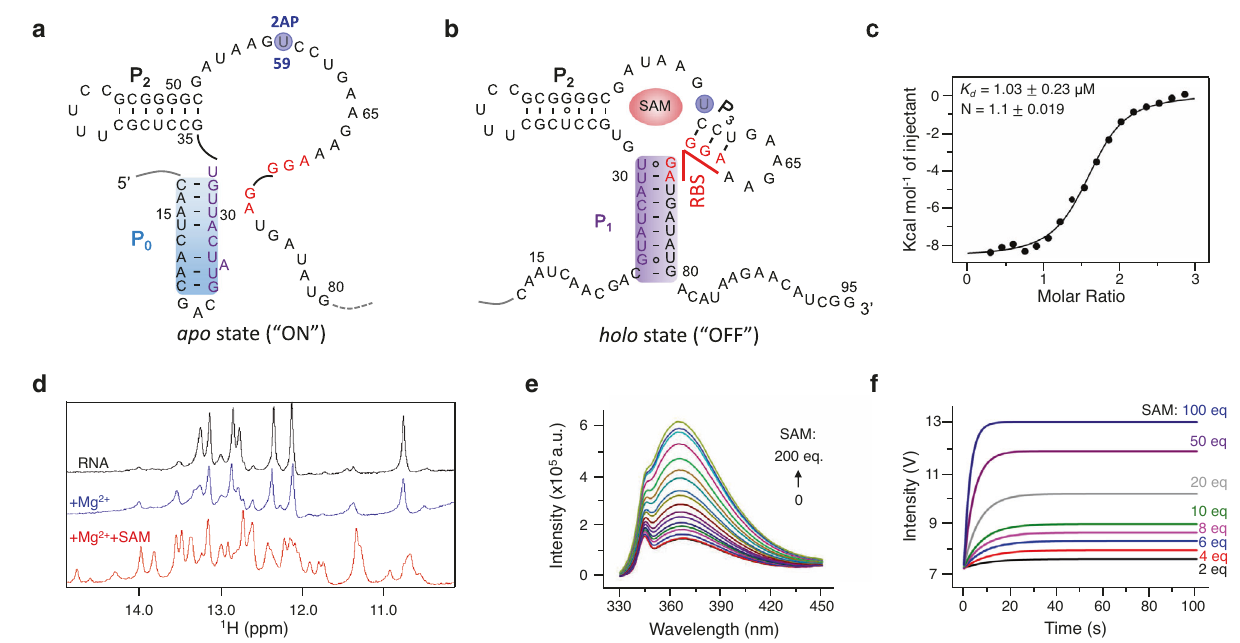
d TheNMRspectraofriboSAM(blackcurve),with2mMMg 2+ (bluecurve)andwith 2mMMg 2+ and0.5mMSAM(redcurve). e Thesteady-state fl uorescencespectraof 0.5 μ MriboSAMinthepresenceof2mMMg 2+ and0 – 200-foldSAM. f Thestopped- fl ow kinetic curves of 0.5 μ M riboSAM after rapidly mixing with 2 – 100-foldSAM in thepresenceof2mMMg 2+ .TheUatsite59,bluehighlightedin( a )wasreplacedby 2AP to collect the data shown in ( e ) and ( f